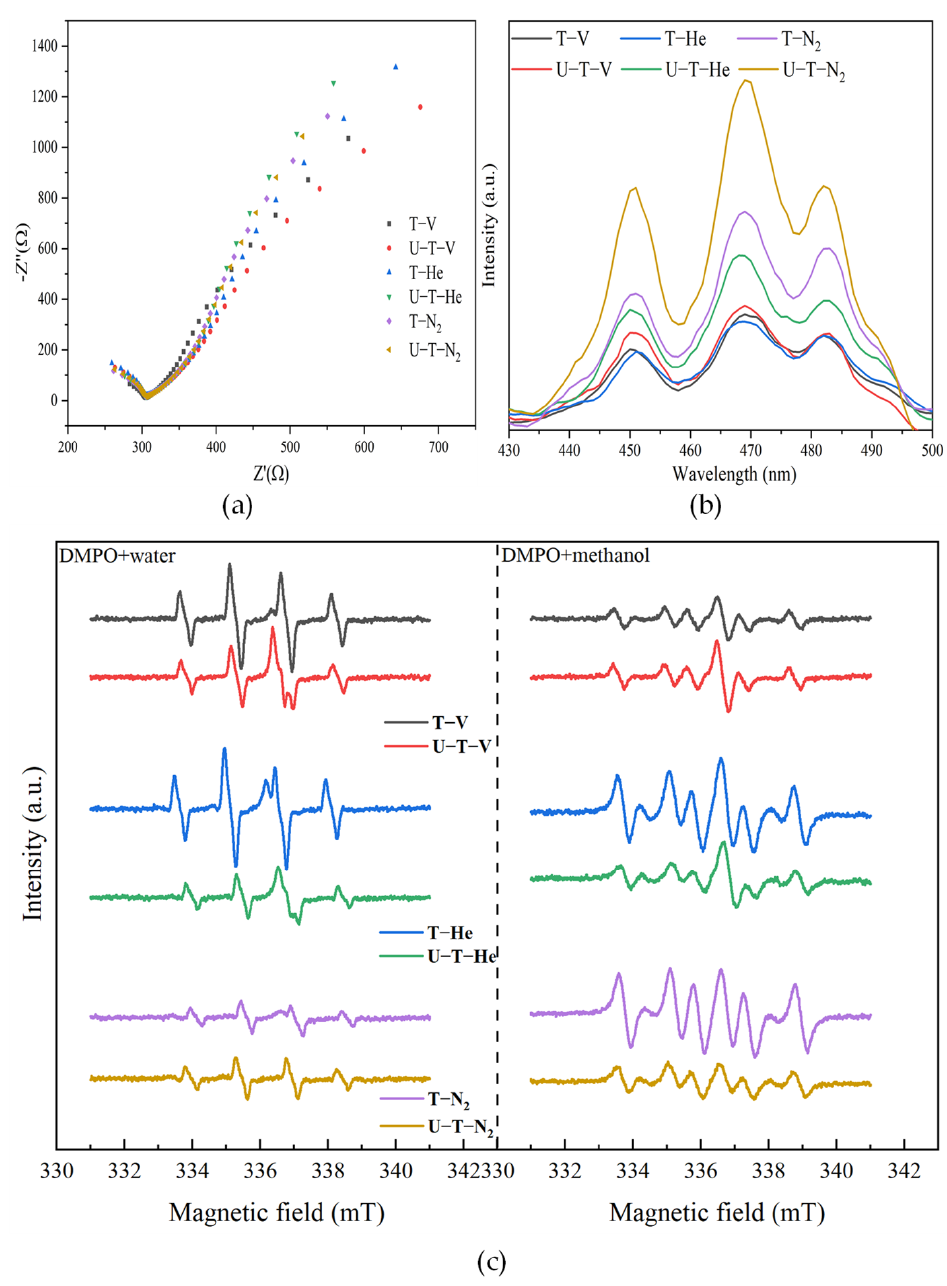
Figure 5. ( a ) EIS Nyquist plots of the samples; ( b ) PL emission spectra of the samples; ( c ) EPR spectra of DMPO adducts obtained in DMPO+water and DMPO+methanol system over the samples after visible-light irradiation for 1 min.